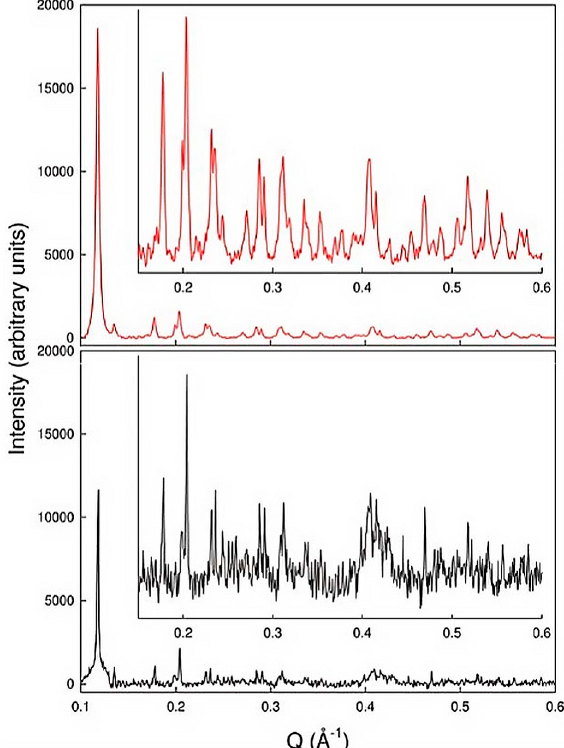
Figure 2. XRPD profiles of MAYV nsP3 macro domain collected at two different beamlines at the ESRF (background). Upper Panel: The materials science beamline ID11, RT, λ = 0.3492 Å. Lower Panel: The high-resolution powder diffraction beamline ID31, RT, λ = 1.29984 Å. Insets correspond to magnifications of profile selected regions [69].